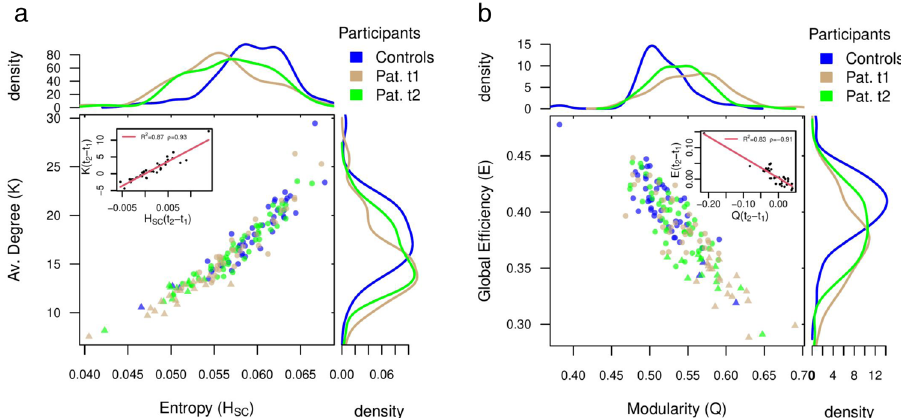
Fig. 4 Alterations in network topology and associated changes in criticality regime. a Average degree ( K ) versus connectivity disorder (i.e., structural entropy H SC ) for all patients and controls. Controls are colored in blue ( n = 46). Brown dots represent patients at t 1 (3 months post-stroke, n = 54), while green dots at t 2 (12 months post-stroke, n = 59). Normalized density plots (histograms) are also shown. Triangular dots correspond to patients who have S 2 monotonic decay and so lack of criticality. In the inset we show the recovery indexes (see main text) show the (linear) correlation, ρ and the R 2 . Normalization of both, the average degree and the connectivity disorder, from t 1 to t 2 supports the corresponding recovery of patients criticality. b The same as a but for the global ef fi ciency ( E ) and modularity ( Q ). Strokes cause an overall decrease in global ef fi ciency at the cost of an associated increase in modularity, but that recovers from t 1 to t 2 towards the controls. Source data are provided as a Source Data fi